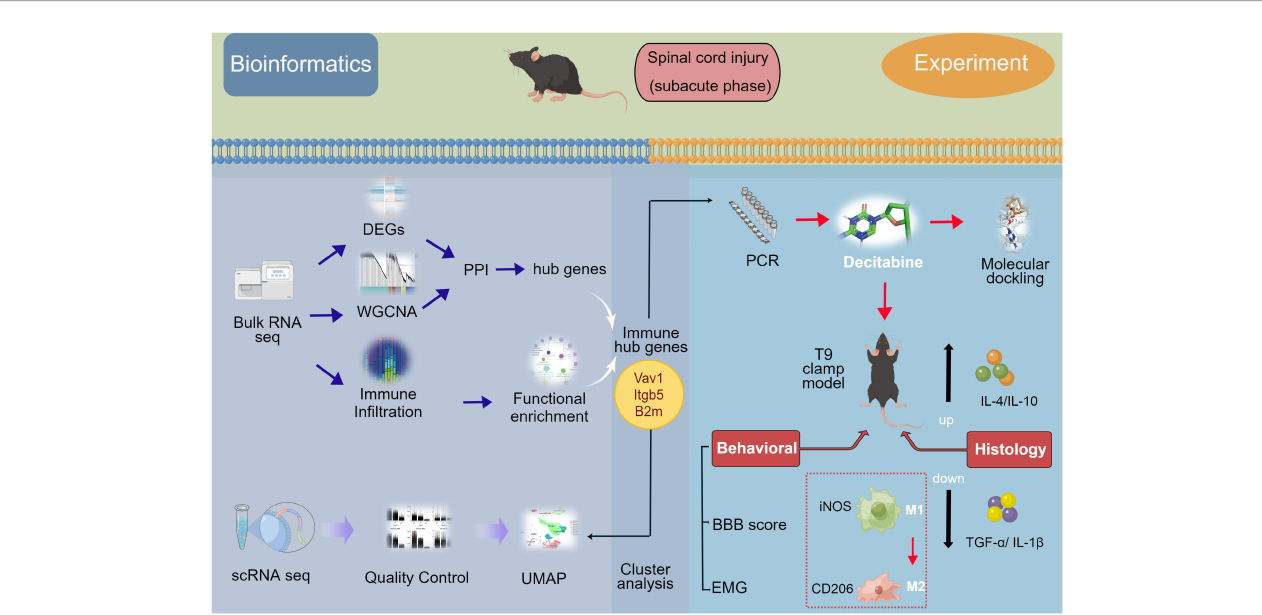
FIGURE 1 Flow-diagram for the study. SCI, spinal cord injury; DEGs, differentially expressed genes; PPI, protein-protein interaction; WGCNA, weighted gene coexpression network analysis (WGCNA); UMAP, uniform manifold approximation and projection; BBB score, Basso-Beattie-Bresnahan locomotion testing score; EMG,